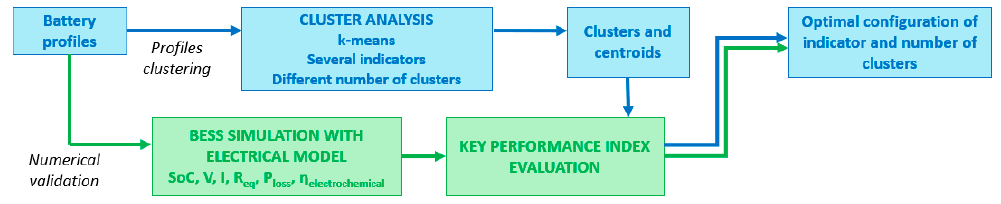
Figure 5. Battery profiles clustering and numerical validation -flowchart of the procedure adopted.